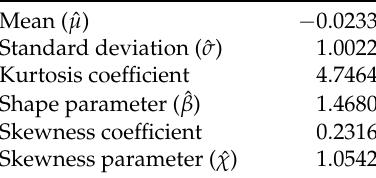
Table A7. Descriptive statistics for standardized residuals ˆ ν t